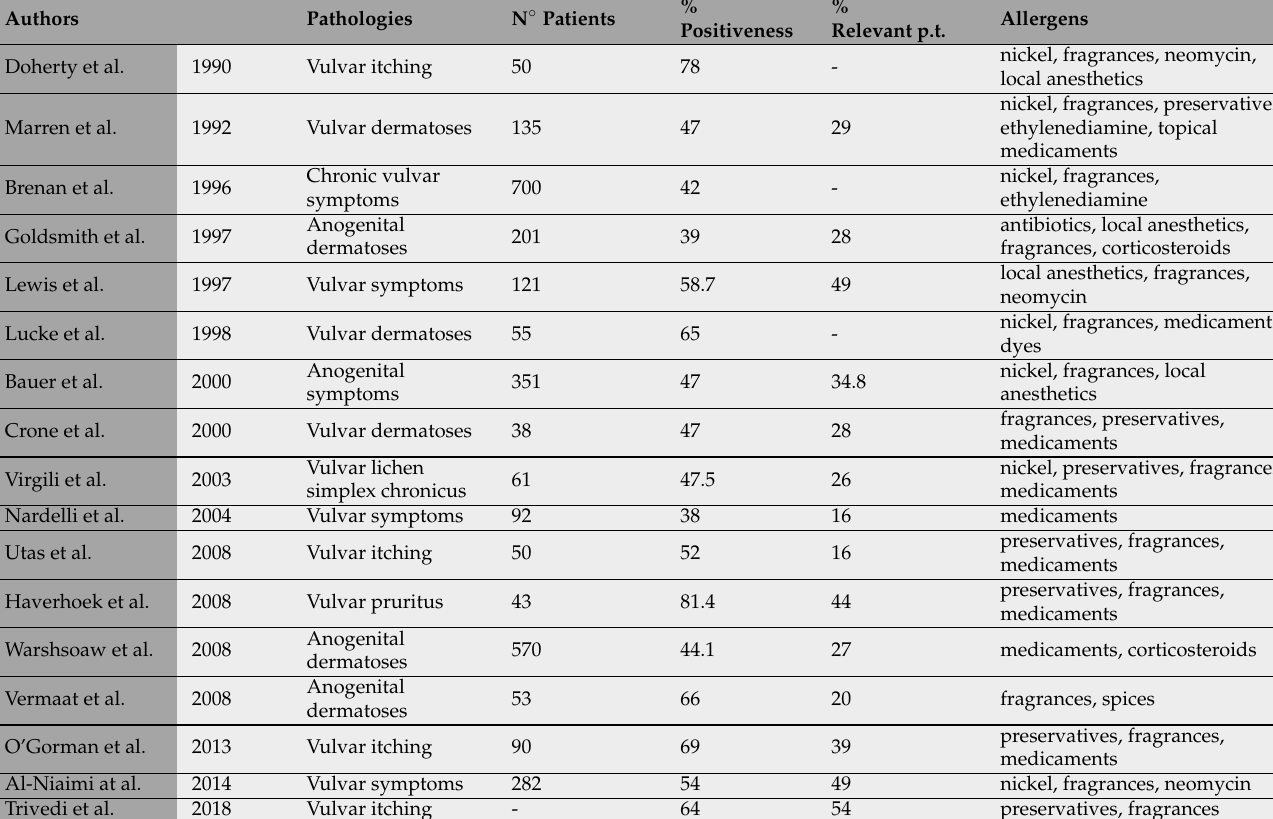
Table 2. Review of the studies concerning vulvar ACD.